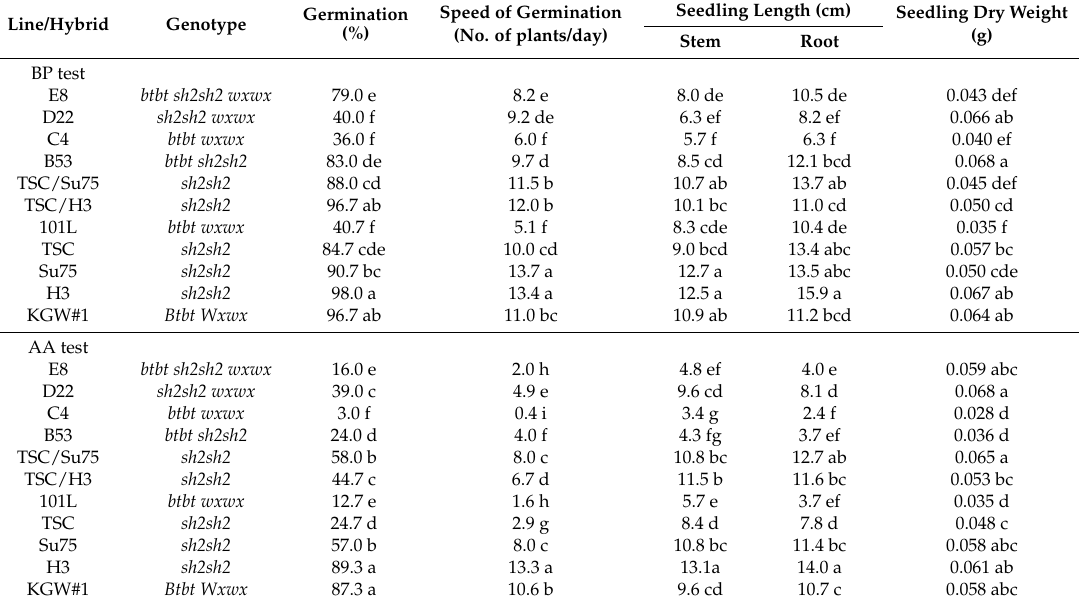
Table 2. Germination percentage, speed of seed germination, seedling length of root and stem and seedling dry weight under standard test between papers (BP test) and accelerated aging test (AA